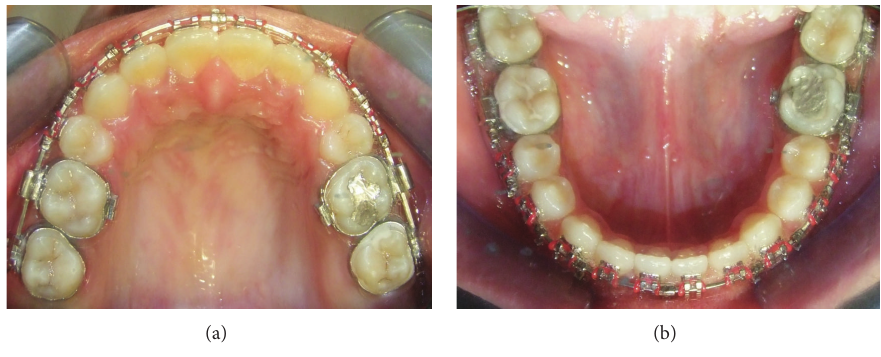
Figure 10: Presurgical: (a) upper, and (b) lower